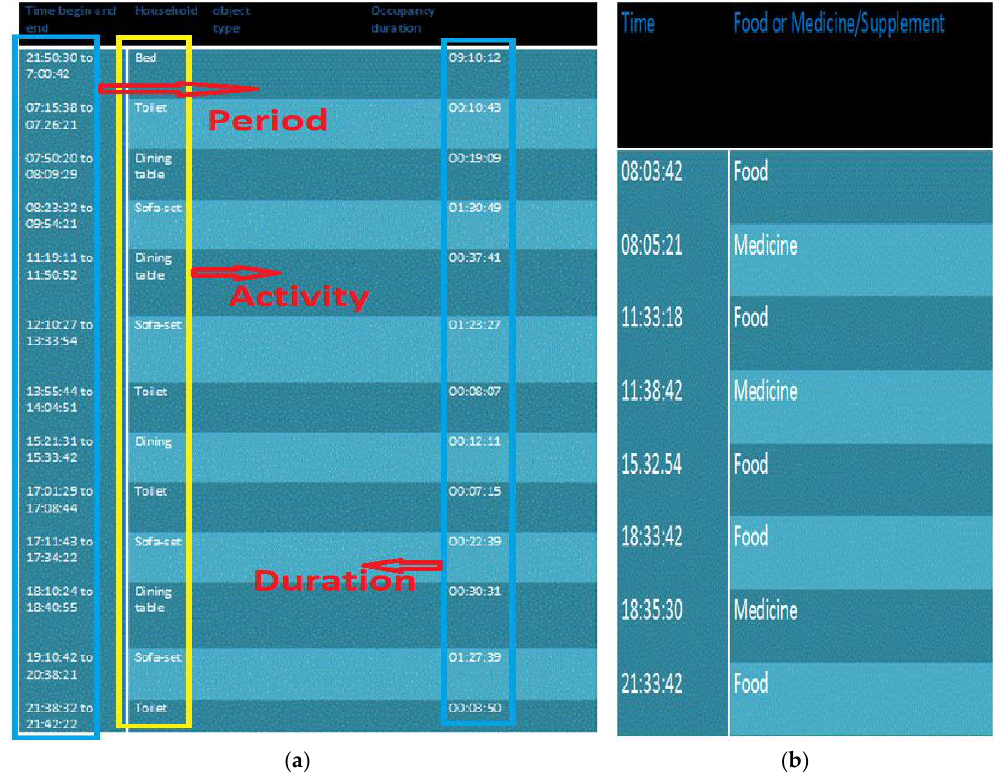
Figure 9. ( a ) The activities during the course of the day. ( b ) The activities of taking medication and food during the course of the